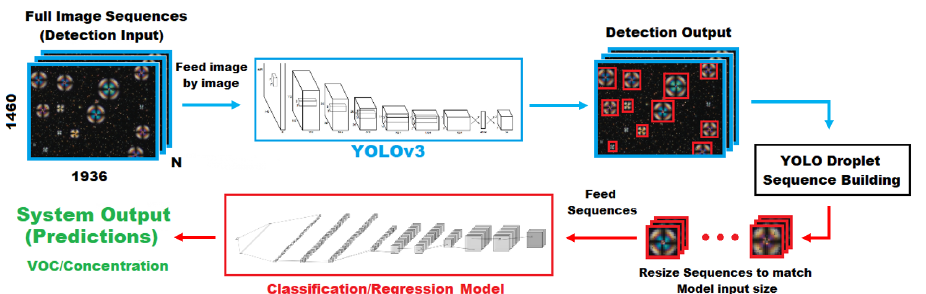
Figure 3. Full architecture of video analysis system. YOLOV3 is responsible for detecting the droplets. These droplets are assembled into sequences and resized prior to being fed to the classification or regression